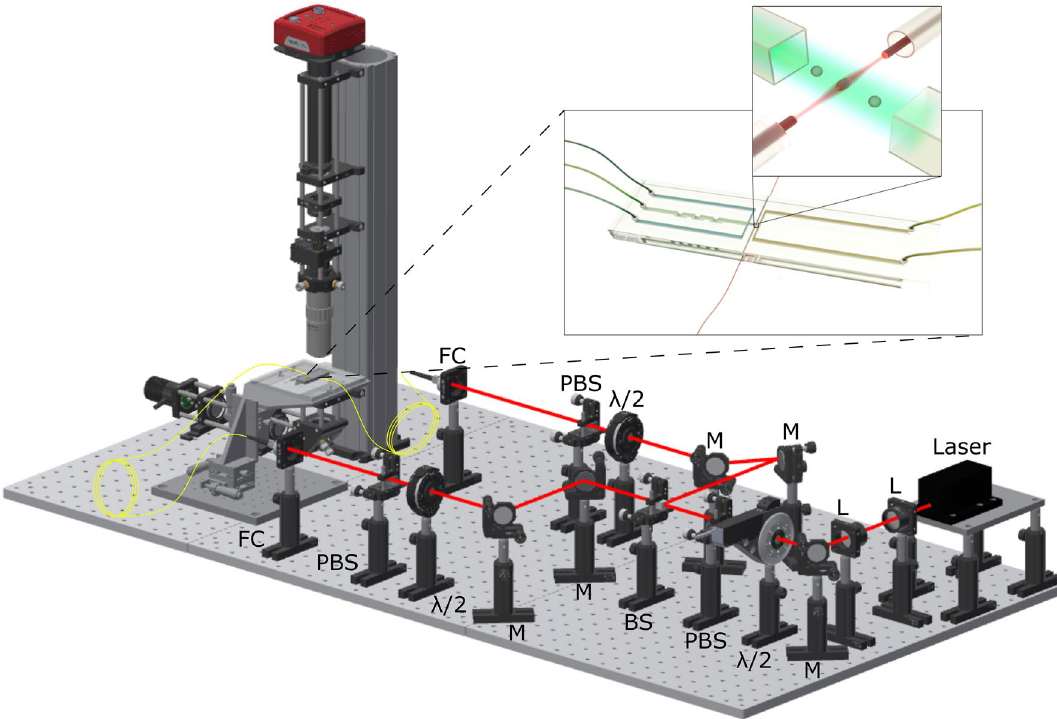
Figure 6. Setup of the dual beam optical trap experiment. The laser beam is divided into two beams with equal power and coupled into single mode fibers. The counterpropagating beams exiting the two optical fibers trap the particles and cells in the microfluidic channel. The dual beam optical trap is illuminated with a white light LED from the bottom side and imaged using a 50 × long working distance objective onto a high speed CCD